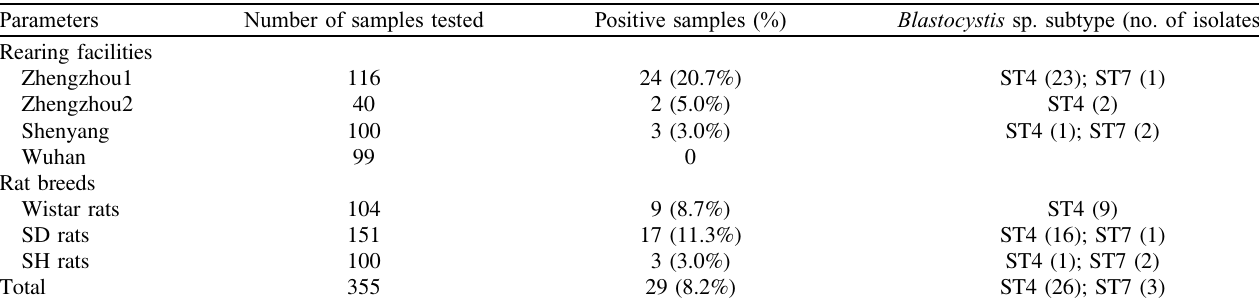
Table 1. Occurrence and genotypic distributions of Blastocystis sp. in laboratory rats in China.